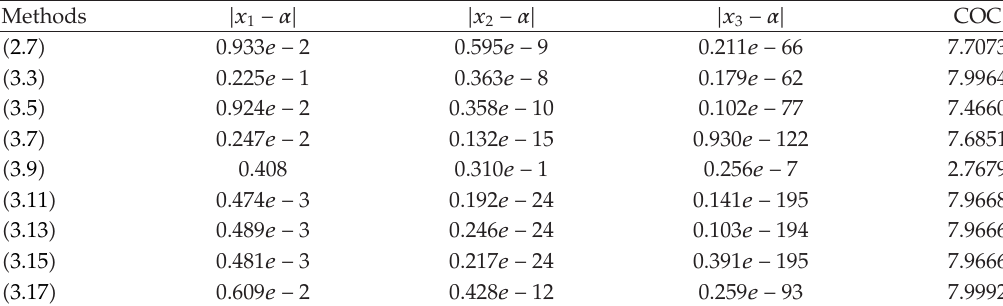
Table 5: Errors occurring in the estimates of the root of (cid:3) 4.5 (cid:4) by the methods described.